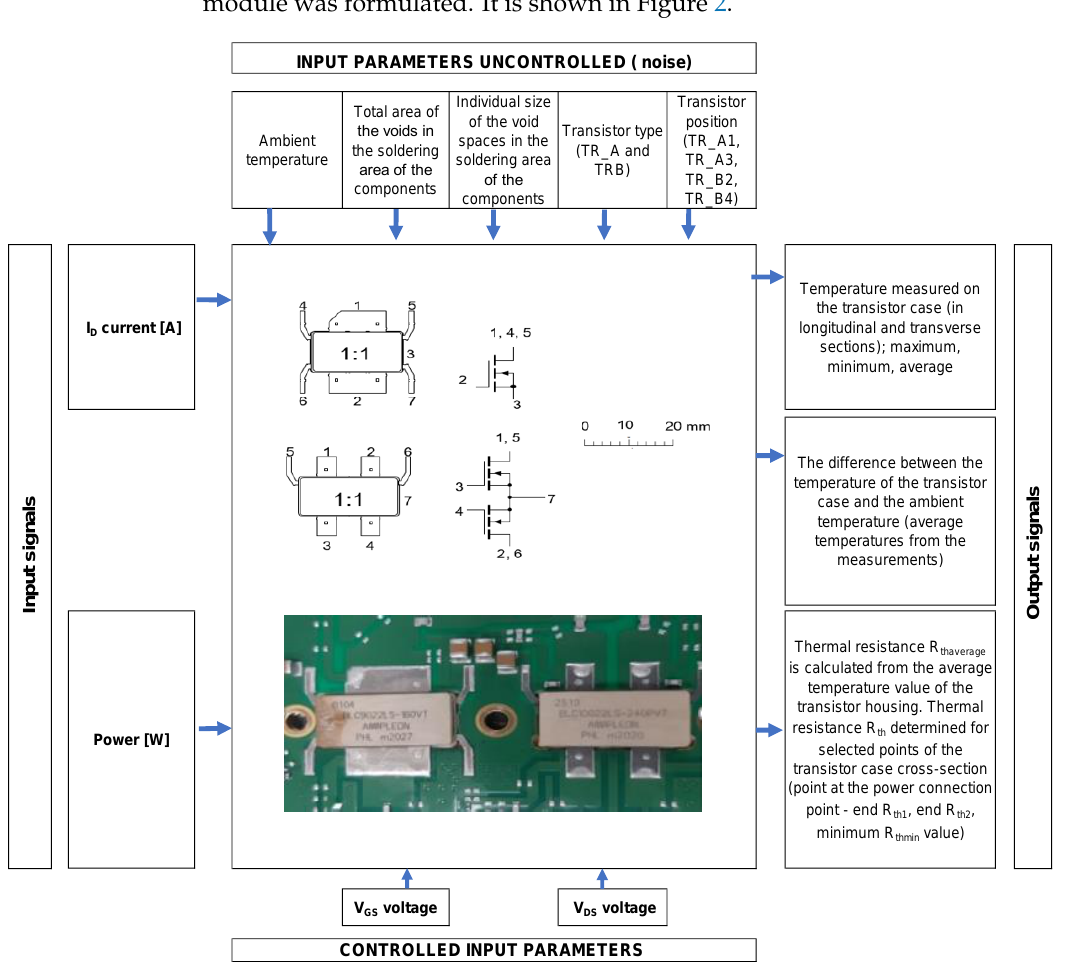
Figure 2. P-diagram with inputs, control and noise parameters ’ influence on the output data of the tested transistors in PCB.